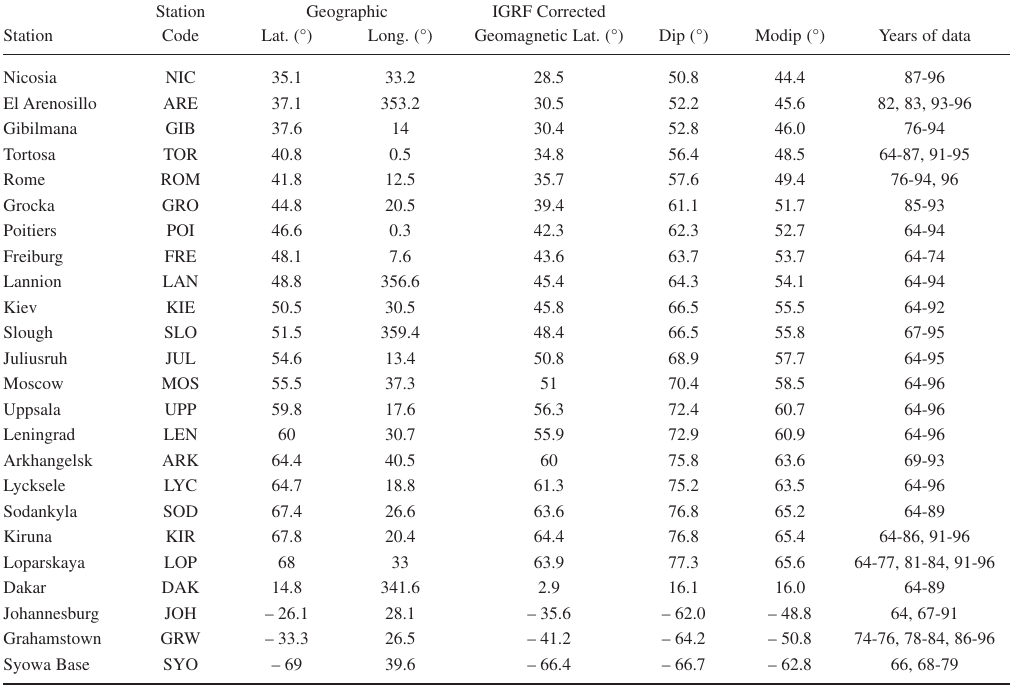
Table I. List of stations and years of f o F 2 data used in the analysis. The geomagnetic latitude is calculated by the International Geomagnetic Reference Field for the year 1986 for a 300 km height. Dip inclination angle and Modip (Rawer, 1963) are calculated for